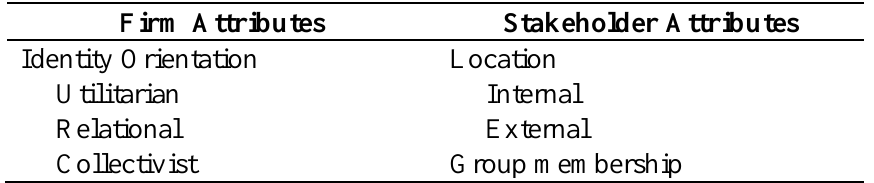
Table 1. Stakeholder